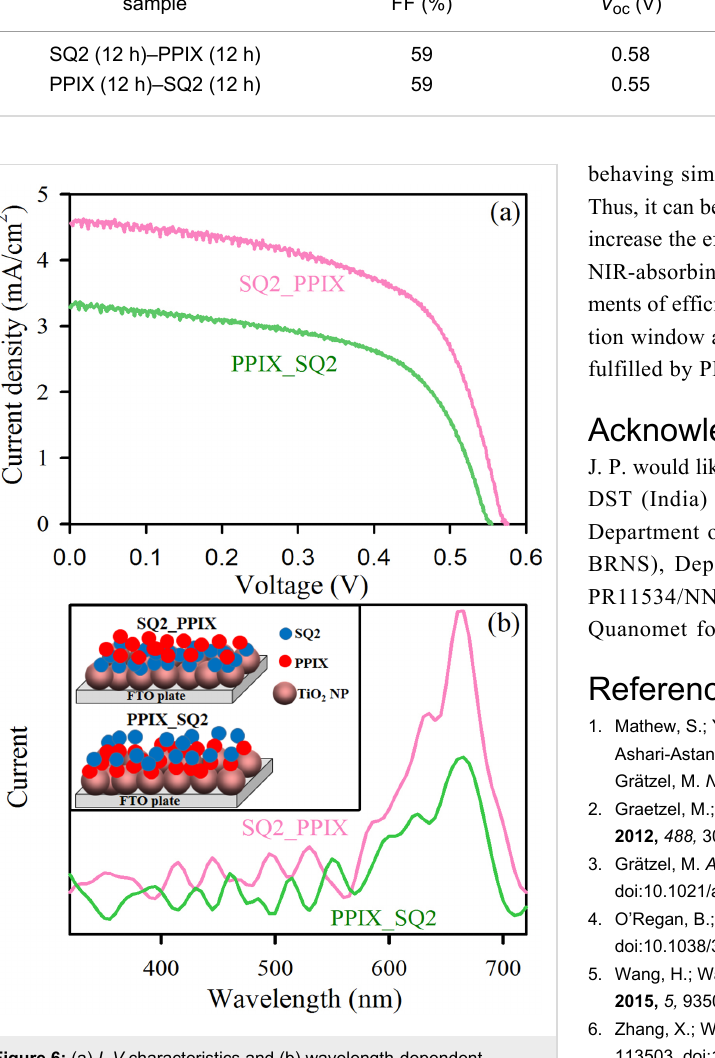
Table 5: Performances of DSSCs using one-by-one sensitization of SQ2 and PPIX. sample